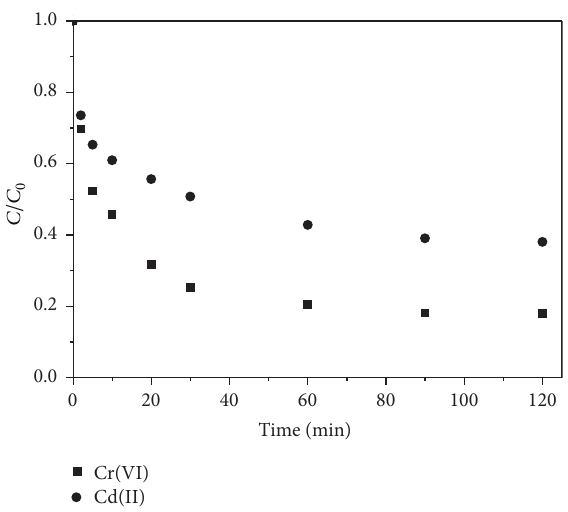
Figure 3: Removal of Cr(VI) and Cd(II) simultaneously using Fe@SiO 2 . Initial Cr(VI) and Cd(II) concentration: 70mg ⋅ L −1 , Fe dose: 0.15 g ⋅ L −1 , pH: 6.0 ± 0.1 , and temperature: 25 ∘